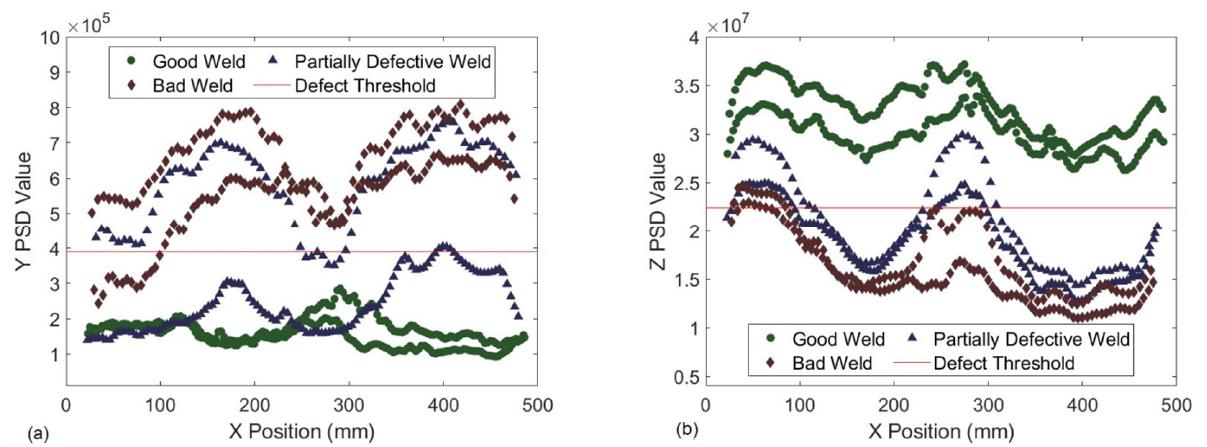
Figure 9. An example threshold of Y ‐ axis PSD data shown in part ( a ) and Z ‐ axis force PSD data shown in part ( b ). Good welds were produced with parameter sets 1–3, partial welds included parameter sets 3–6; and bad welds included parameter sets 5 & 6 in Table 1.